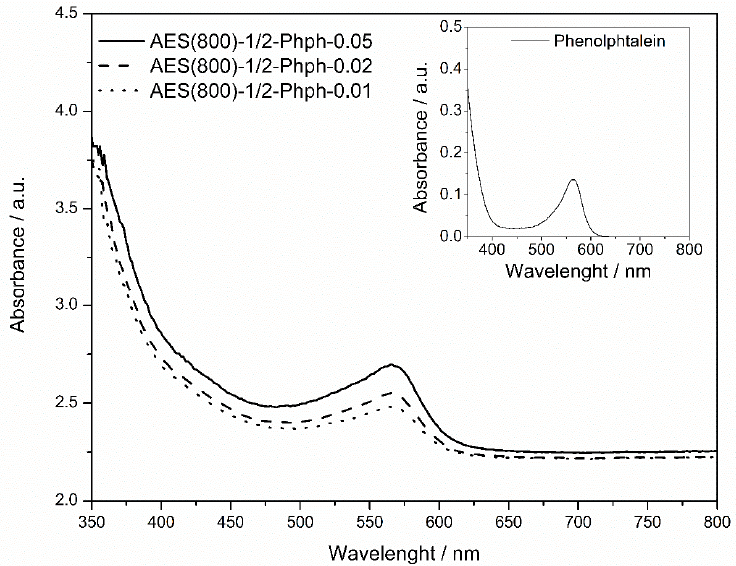
Figure 4. Absorption spectra of AES based FFT doped films. Inset: absorption spectrum of the basic form of Phph in ethanol.